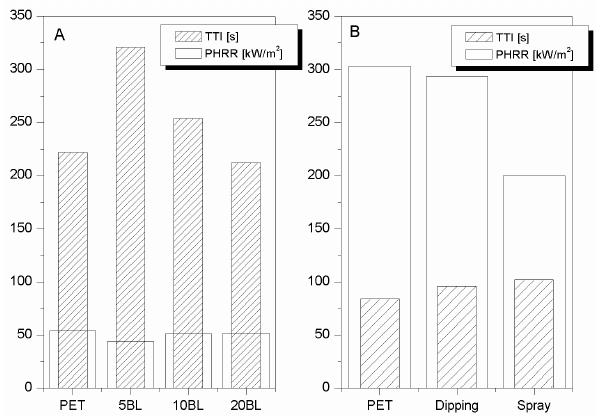
Figure 8. TTI and PHRR values of 171 g/m 2 PET fabrics treated with 5, 10, and 20 BL of silica/silica nanoparticles deposited by dipping ( A ) [25]. Comparison between same LbL architectures deposited by dipping and spray on 490 g/m 2 PET ( B ) [26]. Data obtained by cone calorimetry at 35 kW/m 2 .